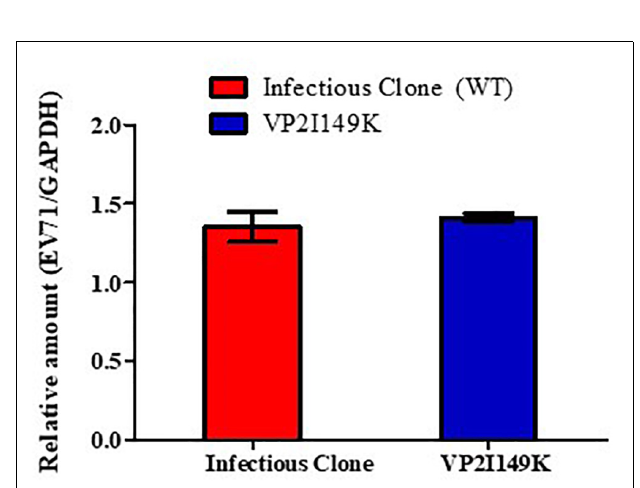
FIGURE 4 | Binding assay. NSC-34 cells were infected with either WT or VP2 I149K mutant (MOI of 10) at 4 ◦ C for 1 h. The cells were washed and pelleted, and viral RNA was extracted and processed for RT-PCR. The viral RNA titers were normalized to GAPDH RNA levels. One representative set of two independent experiments is shown. Data were expressed as mean ±